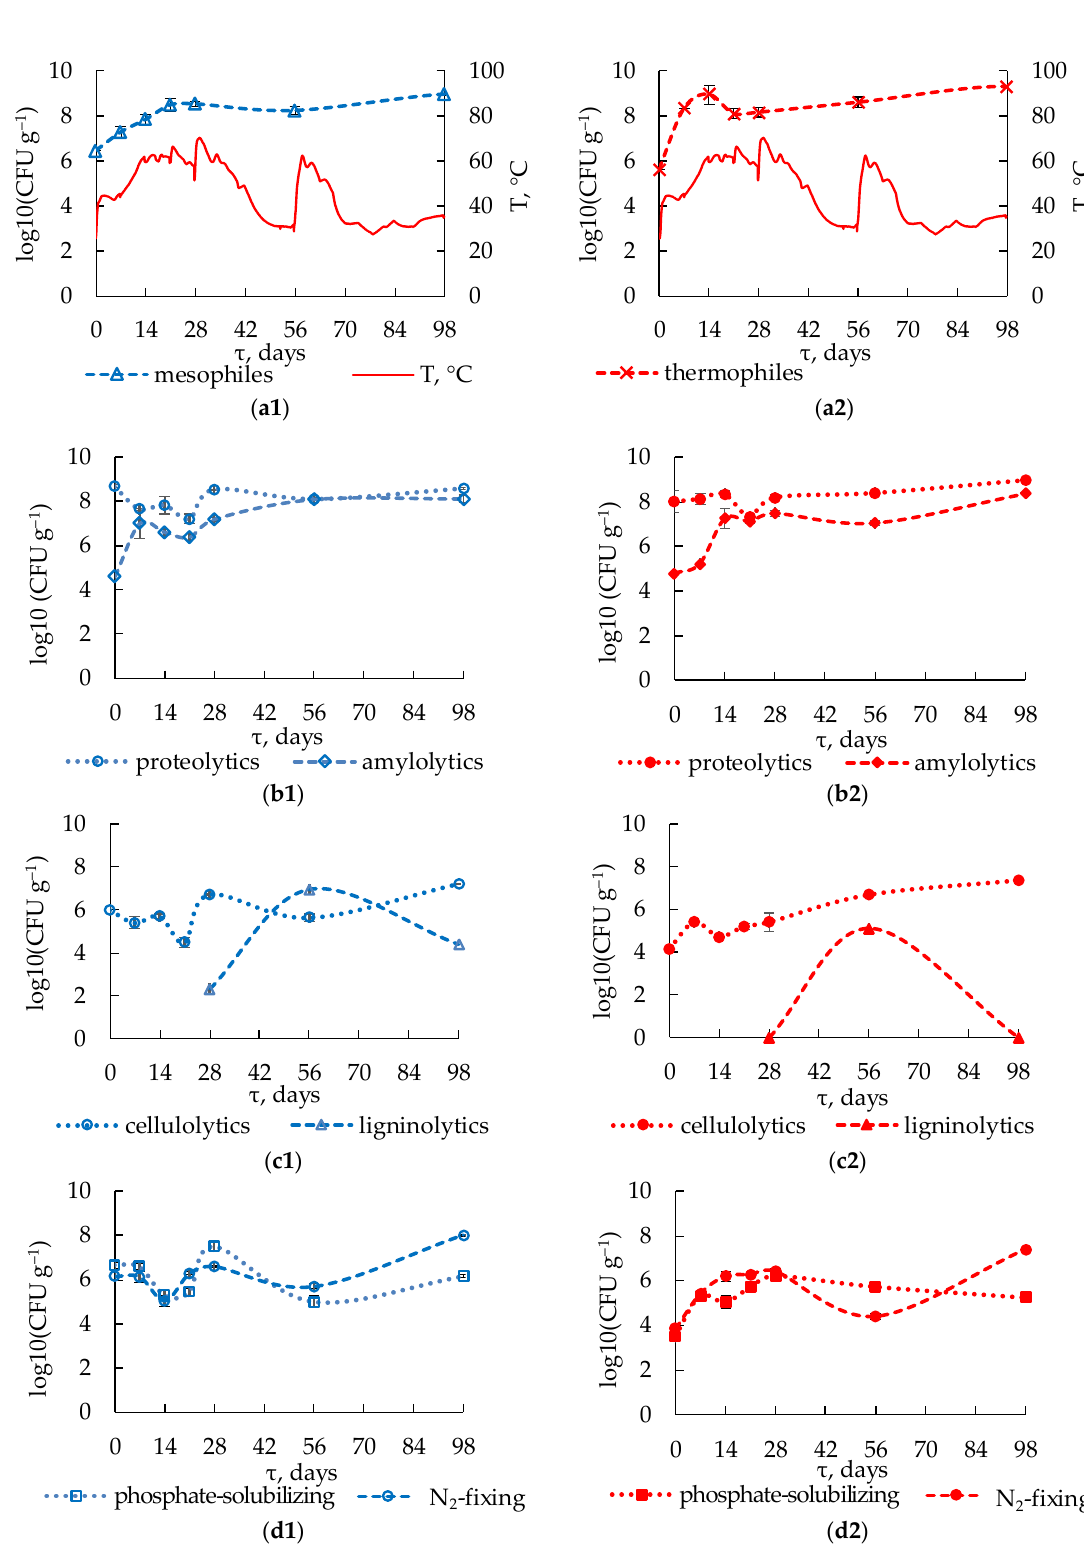
Figure 3. Dynamics of cultured microorganisms during composting: ( a ) total microbial number in mesophilic and thermophilic conditions: T, substrate temperature; ( b ) proteolytic and amylolytic microorganisms; ( c ) cellulolytic and ligninolytic microorganisms; ( d ) phosphate-solubilizing and nitrogen-fixing microorganisms; 1, mesophilic microorganisms; 2, thermophilic microorganisms.